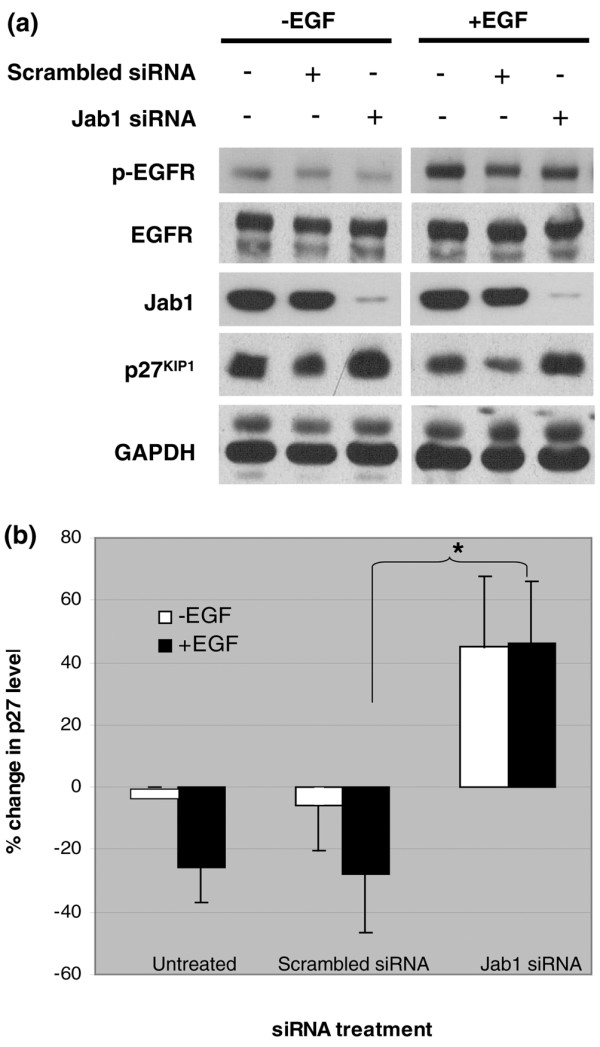
Effect of Jab1 short interfering RNA (siRNA) knockdown on p27 levels with and without epidermal growth factor (EGF) treatment in MDA-MB-231 cells. (a) Western blot analysis of cell lysates collected following the indicated treatments. Relative p27 band intensities were calculated by densitometry and normalized to the loading control (GAPDH). (b) The percentage change in p27 expression for EGF-treated cells relative to untreated controls. Data shown are representative of several independent experiments, demonstrating that knockdown of Jab1 abrogates EGF-induced downregulation of p27. Bars represent mean ± standard deviation. Statistical analysis was by t test (*P < 0.0001). All EGF treatments were at 50 ng/mL for 4 hours. EGFR, epidermal growth factor receptor; GAPDH, glyceraldehyde 3-phosphate dehydrogenase; Jab1, c-Jun activation domain-binding protein-1; pEGFR, phosphorylated epidermal growth factor receptor.